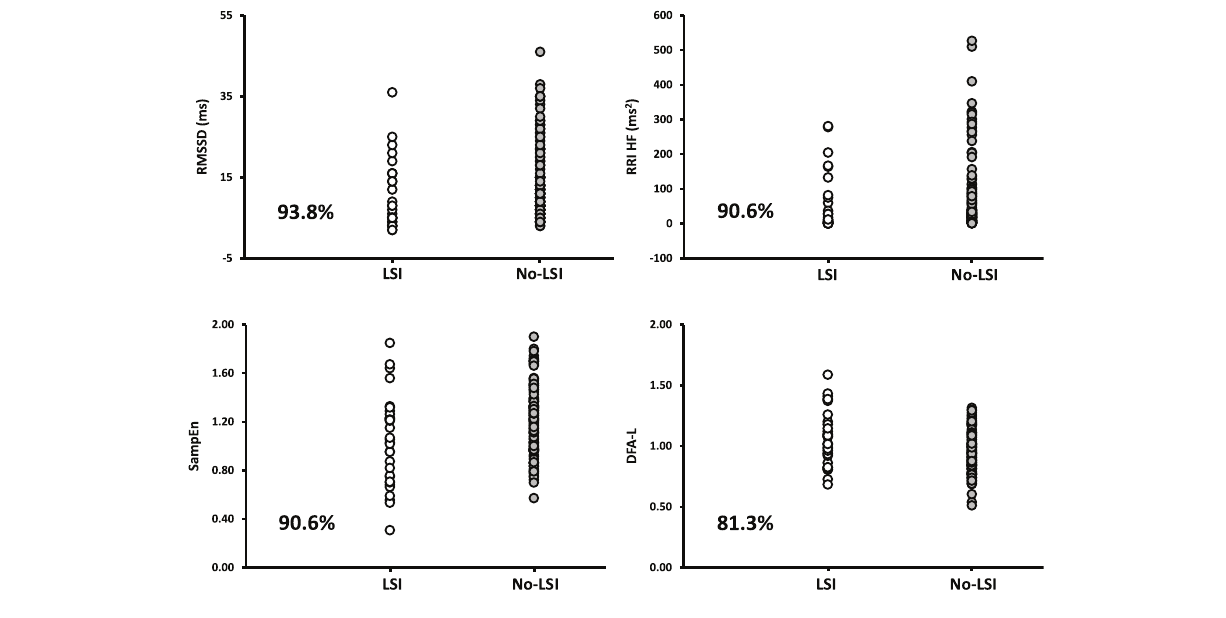
FIGURE 8 | Individual values of four representative heart rate variability metrics for life-saving intervention (LSI; n = 32) and No-LSI ( n = 127) patient groups (each point represents a single patient). For each HRV metric, group means statistically differ between LSI and No-LSI groups ( P ≤ 0.03).The percentage of individual LSI patient values that fall within the